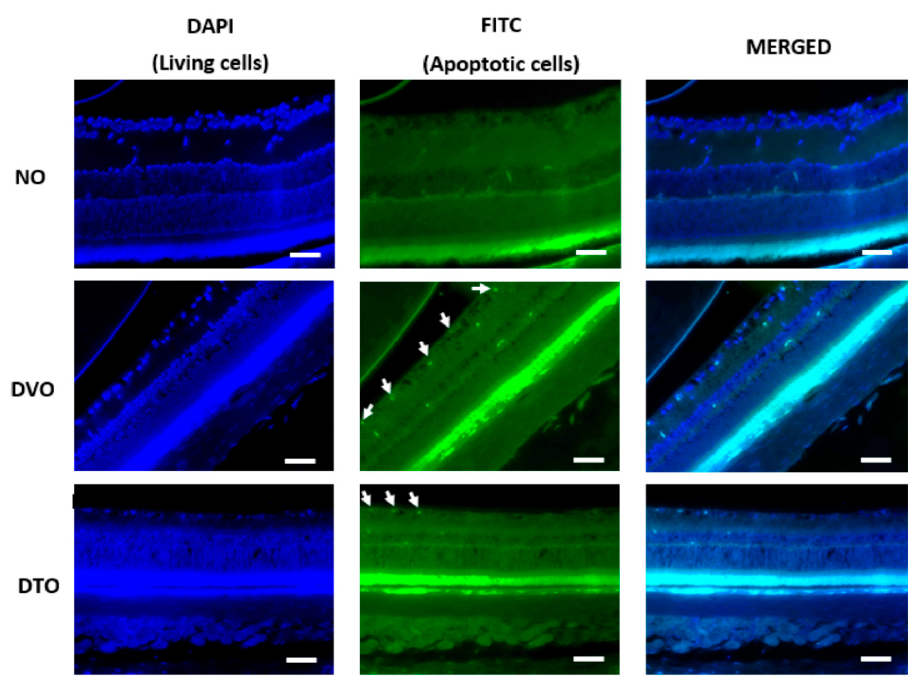
Figure 6. Microphotograph of TUNEL-stained retinal sections, showing the effect of oral TRF on the retinal cell apoptosis (magnification 20×). White arrow: TUNEL positive cells, Left: DAPI; Middle: FITC; Right: DAPI + FITC (Merged). NO: Normal rats with oral vehicle treatment, DVO: Diabetic rats with oral vehicle treatment, DTO: Diabetic rats with oral TRF treatment, GCL: Ganglion cell layer. (Scale bar: 100 μ m).